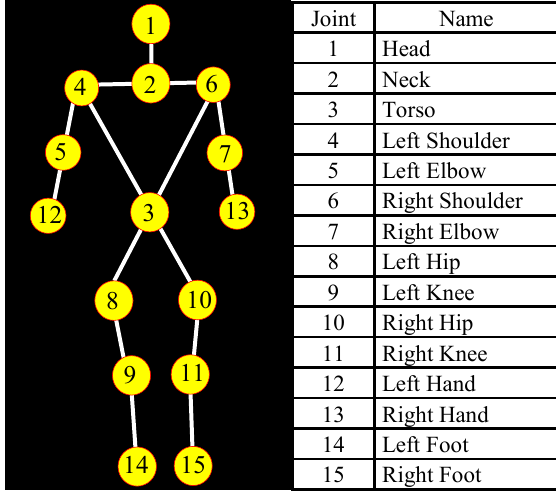
Figure 2. Skeletal joints and their descriptions in the CAD-120 dataset.